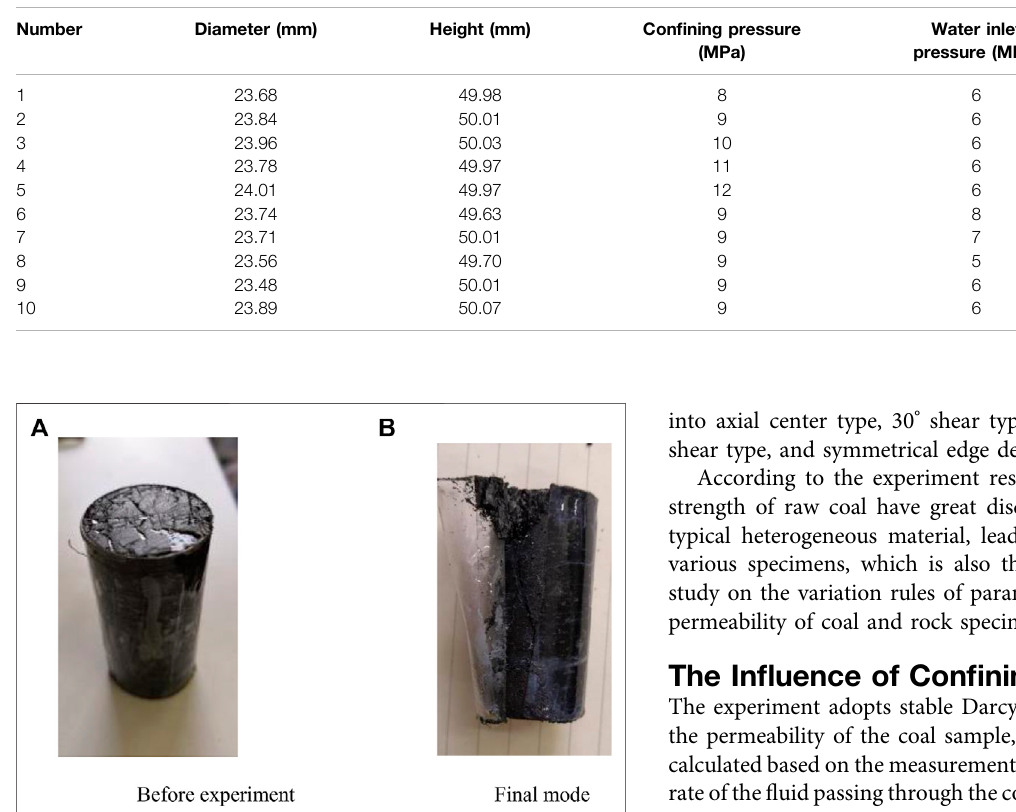
TABLE 1 | Dimensions and loading conditions of test specimens.